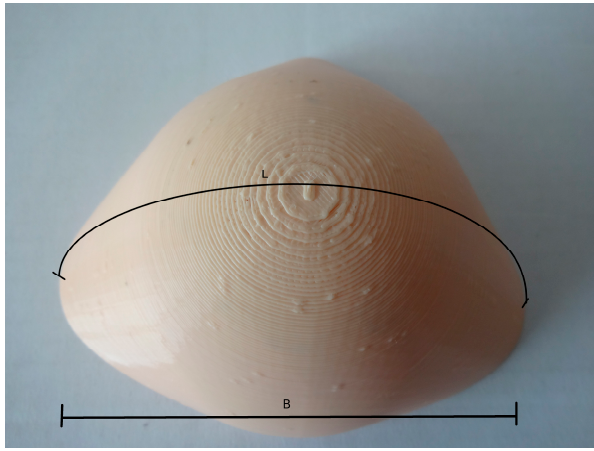
Figure 5. The measurement of the width of the breast (B) or the length over the top (L).